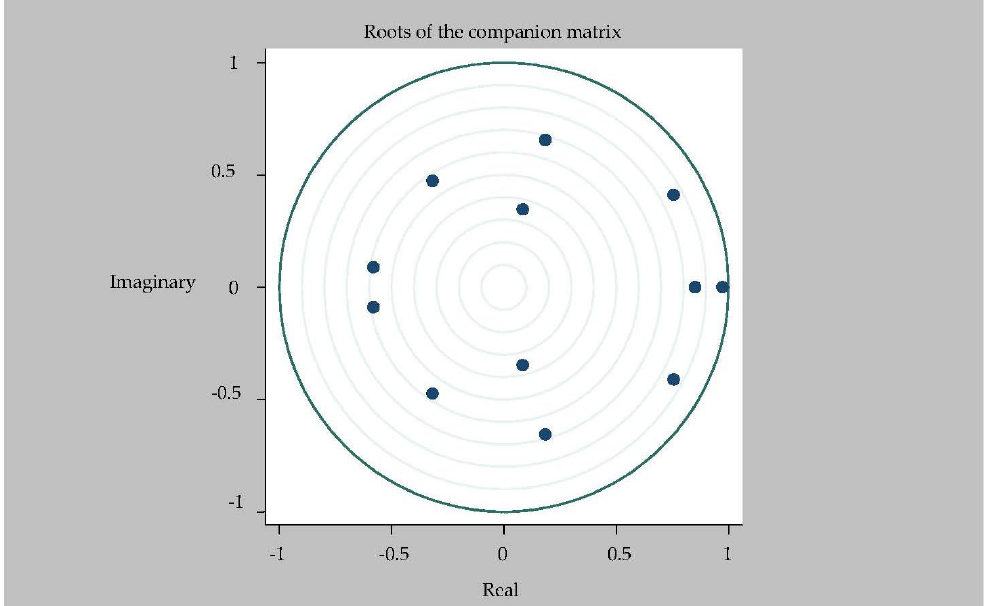
Figure 2. Root mode distribution of characteristic equation of 6-variable SVAR(2) model.